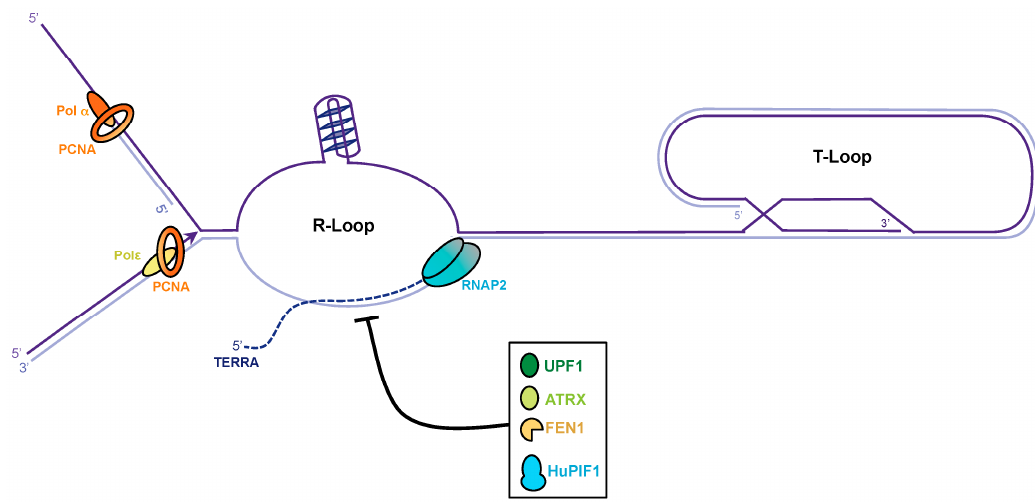
Figure 3. Dissolution of the telomere repeat containing RNA (TERRA) R-loop at telomeres. The C-rich telomeric strand provides the template for TERRA transcription. RNA molecules can anneal to its genomic template co-transcriptionally to generate RNA:DNAhybrids. G4 structures might form at the displaced G-rich strand and stabilize the R-loop. To avoid collisions during replication the TERRA R-loop must be dissolved. RNase H can degrade TERRA but other factors as UPF1, ATRX, FEN1, and PIF1 might also be involved in TERRA R-loop dissolution.